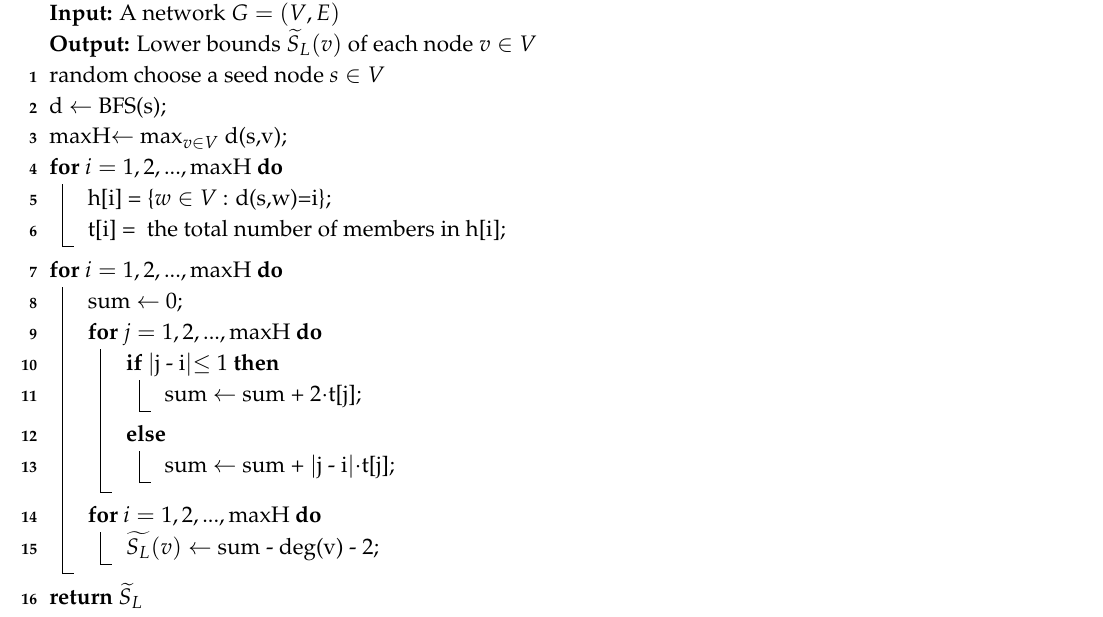
Algorithm 7: Level-based lower bound for undirected